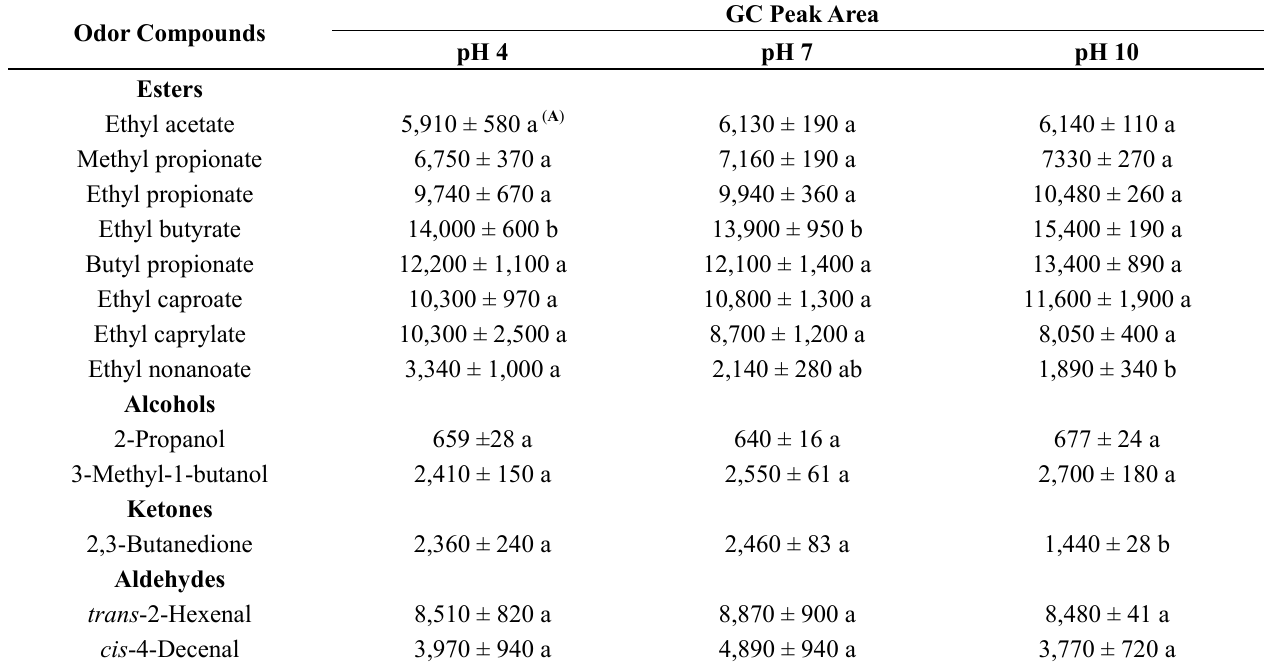
Table 2. Release of odor compounds in original cellulose hydrocolloid system adjusted to pH values of 4, 7, and 10.